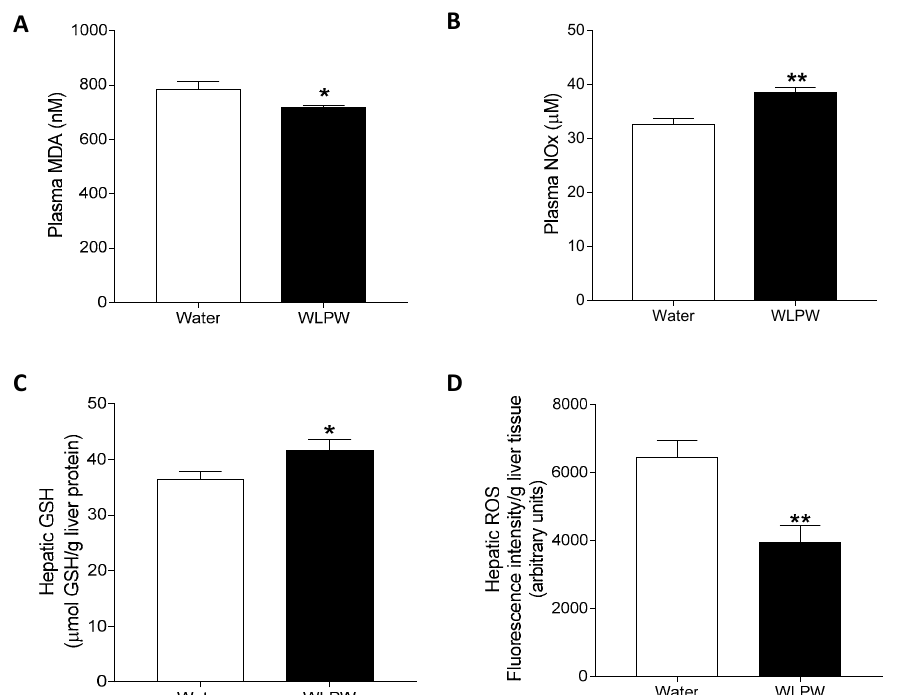
Figure 6. Levels of ( A ) plasma malondialdehyde (MDA) ( B ) plasma nitric oxide metabolites (NOx), ( C ) hepatic reduced glutathione (GSH) and ( D ) hepatic reactive oxygen species (ROS) in spontaneously hypertensive rats 6 h after administration of 125 mg/kg bw dried wine lees powder (WLPW) or water. Data are expressed as mean ( n = 6) ± SEM. Significant differences are represented with (*) or (**) for p < 0.05 or p < 0.01, respectively. p was estimated by Student’s t-test.